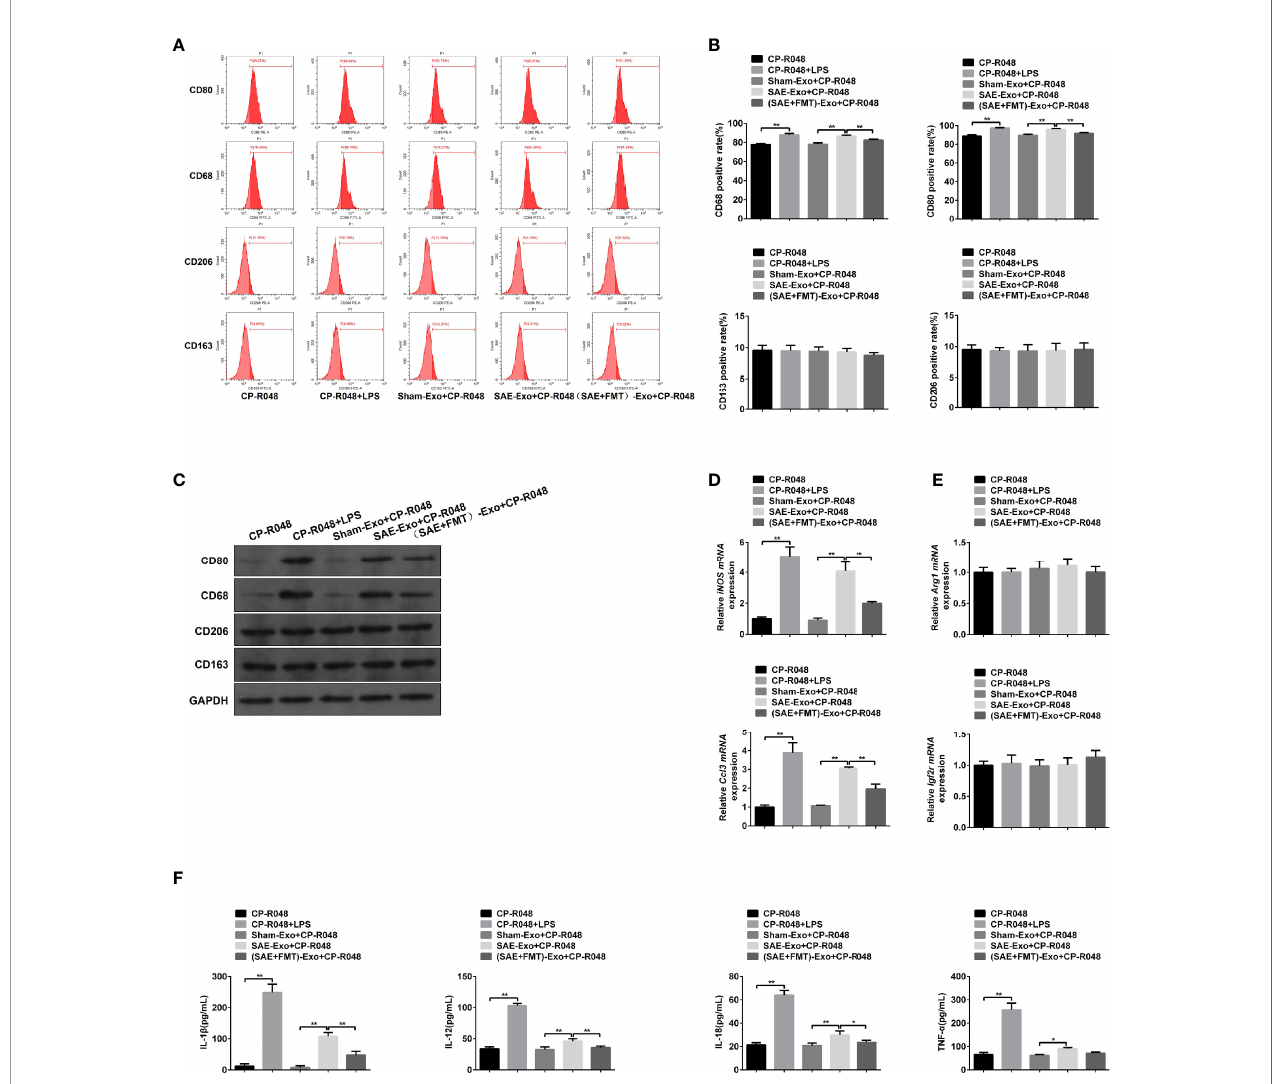
FIGURE 4 | The association between M1 polarization and intestinal epithelial cell exosome. (A) CP-R048 cells were stimulated with LPS, or intestinal epithelial cell exosomes obtained from Sham-operated, SAE, and FMT-challenged SAE rats, respectively. Then, CD80-, CD68-, CD206-, and CD163-positive cells were measured by fl ow cytometry. (B) Quantitative analysis of the proportion of CD80-, CD68-, CD206-, and CD163-positive cells in panel (A) of this fi gure. (C) Protein expression of CD80, CD68, CD206, and CD163 as determined by WB in the CP-R048 cells stimulated with different reagents. Relative mRNA expression of inducible nitric oxide synthase (iNOS) and chemokine (C-C motif) ligand 3 (Ccl3) (D) and arginase (Arg1) and insulin-like growth factor 2 receptor (Igf2r) genes (E) in the CP-R048 cells treated with LPS and a different source of exosomes. (F) The levels of IL-1 b , IL-12, IL-18, and TNF- a were detected by ELISA kits. *P < 0.05. **P <